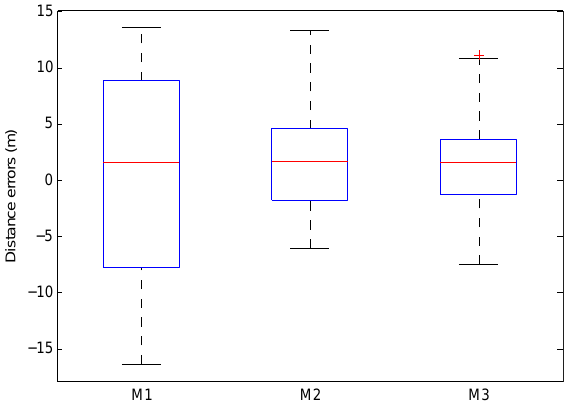
Figure 12. Distance errors between the real and estimated walking